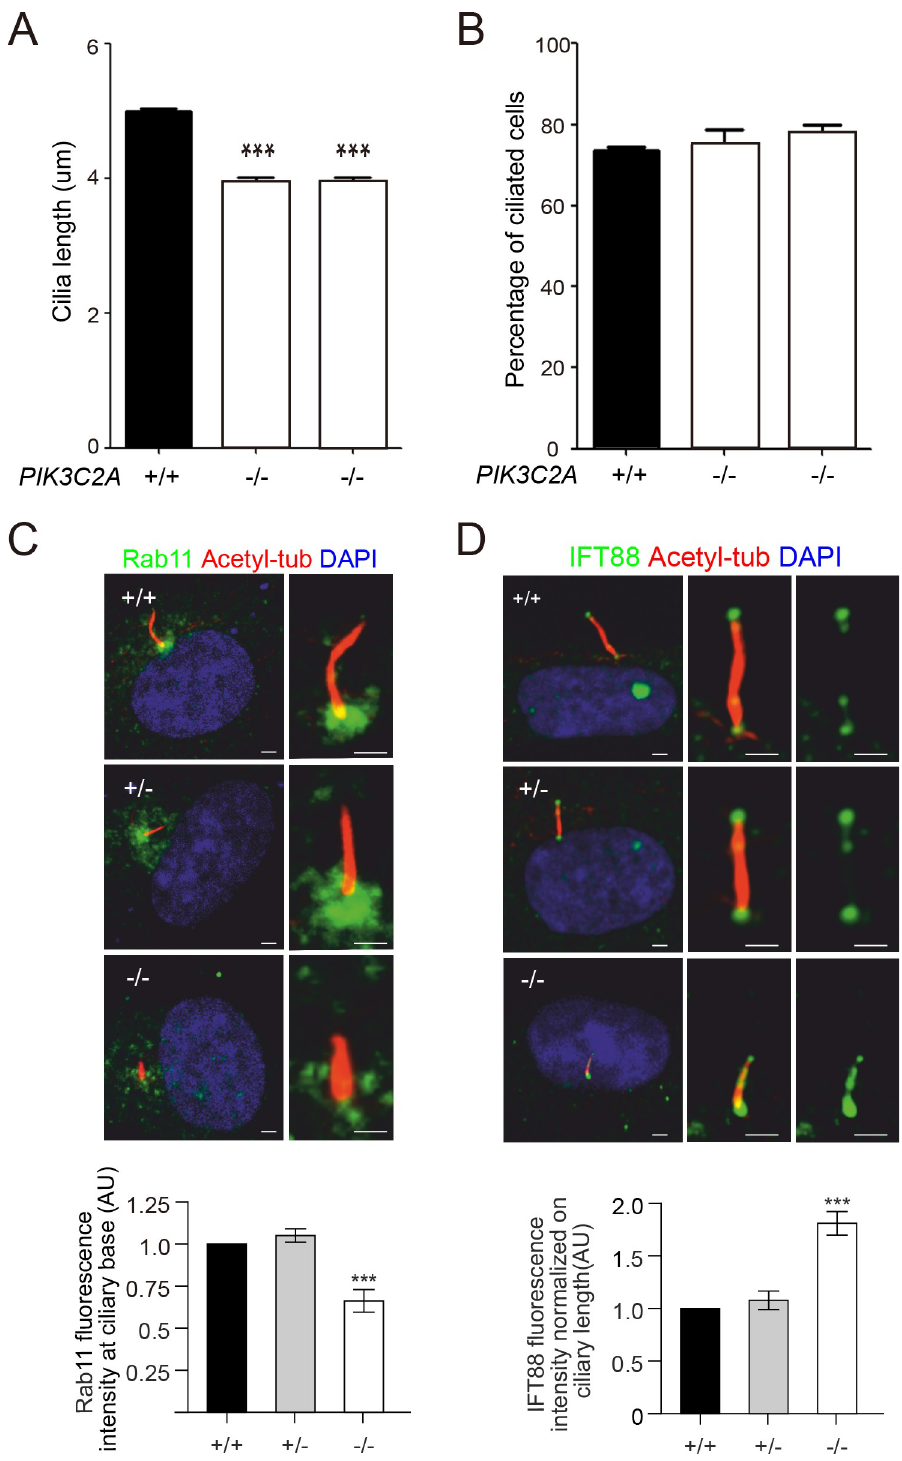
Fig 4. Ciliary defects due to PIK3C2A deficiency in patient-derived fibroblasts. (A) Cilia length and (B) cilia number were determined in primary fibroblasts from two affected individuals and three unrelated controls. Data is represented as mean ± SEM (n > 300/sample). Raw data for cilia length is provided in S6 Table. (C) Immunofluorescence analysis of RAB11 localization at the base of the primary cilium. Results showed that RAB11 is significantly reduced at the base of the primary cilium in -/- cells compared with +/+ and or +/- cells. n = 3 independent experiments and 15